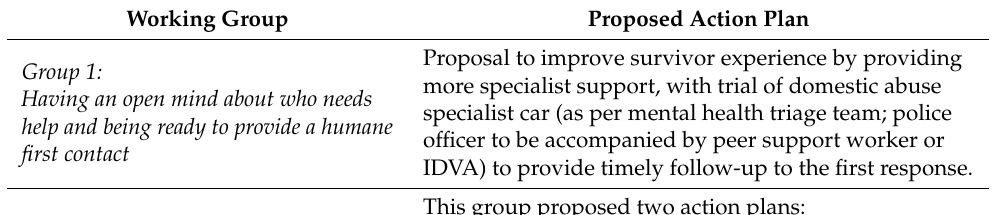
Table 2. Proposed action plans according to working